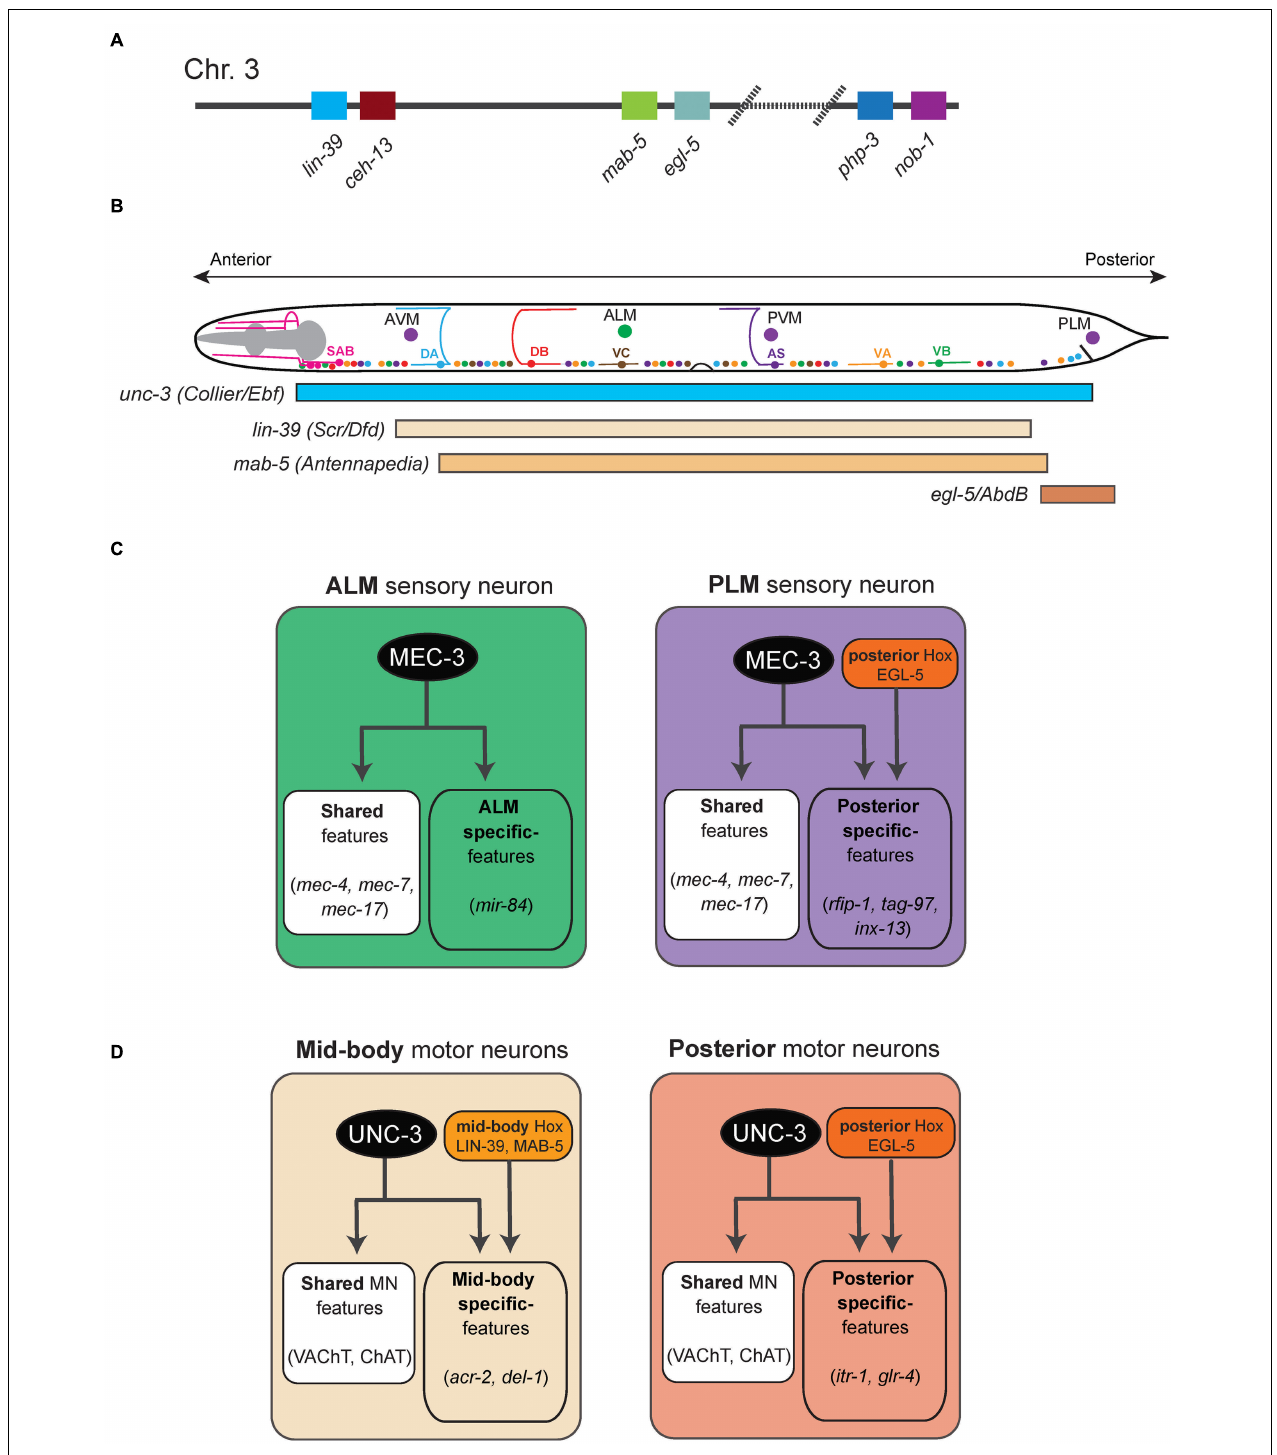
FIGURE 1 | Hox gene functions in mechanosensory and motor neurons in C. elegans . (A) Schematic of the C. elegans Hox gene cluster. (B) Schematic showing the cell body location of mechanosensory neurons (AVM, ALM, PVM, PLM) and cholinergic MNs in the ventral nerve cord (SAB, DA, DB, VA, VB, VC, AS). The GABAergic MNs are not shown. (C) The terminal selector MEC-3 controls ALM and PLM terminal identity. The activity of the posterior Hox gene egl-5 diversifies PLM from ALM. Examples of terminal identity genes are shown in italics. (D) An intersectional strategy for the control of terminal identity of midbody (UNC-3, LIN-39, MAB-5) and posterior (UNC-3, EGL-5) MNs along the A-P axis of the C. elegans ventral nerve cord. See text for details.